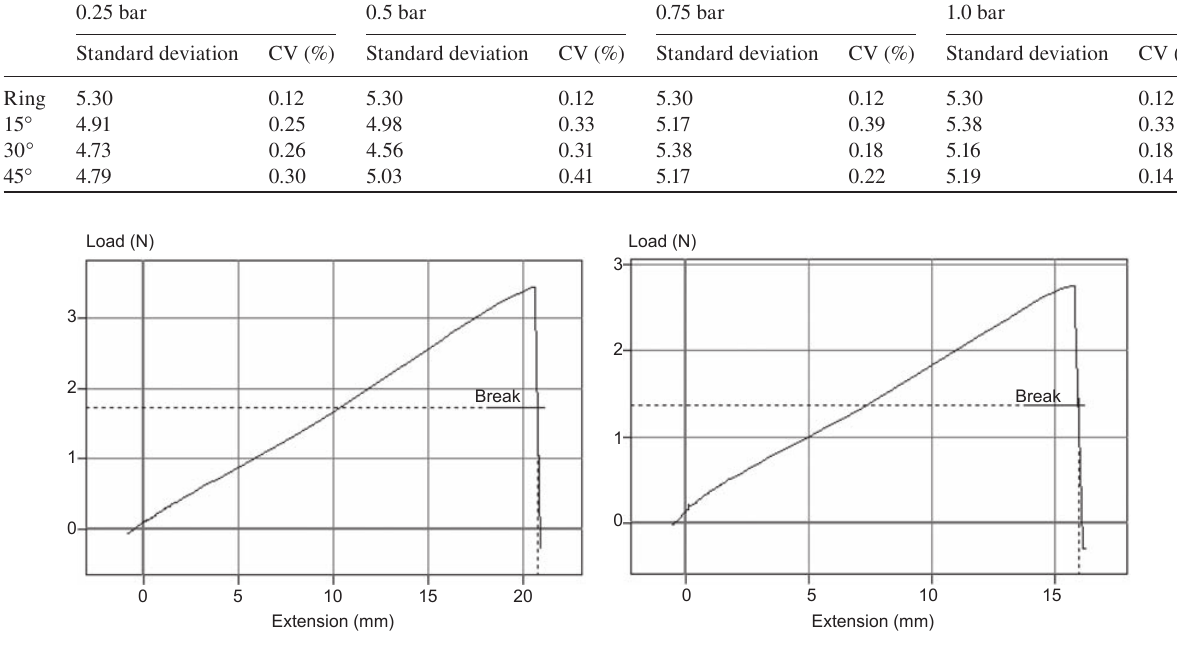
Figure 12 Load-extension curves of the conventional ring spun yarns.